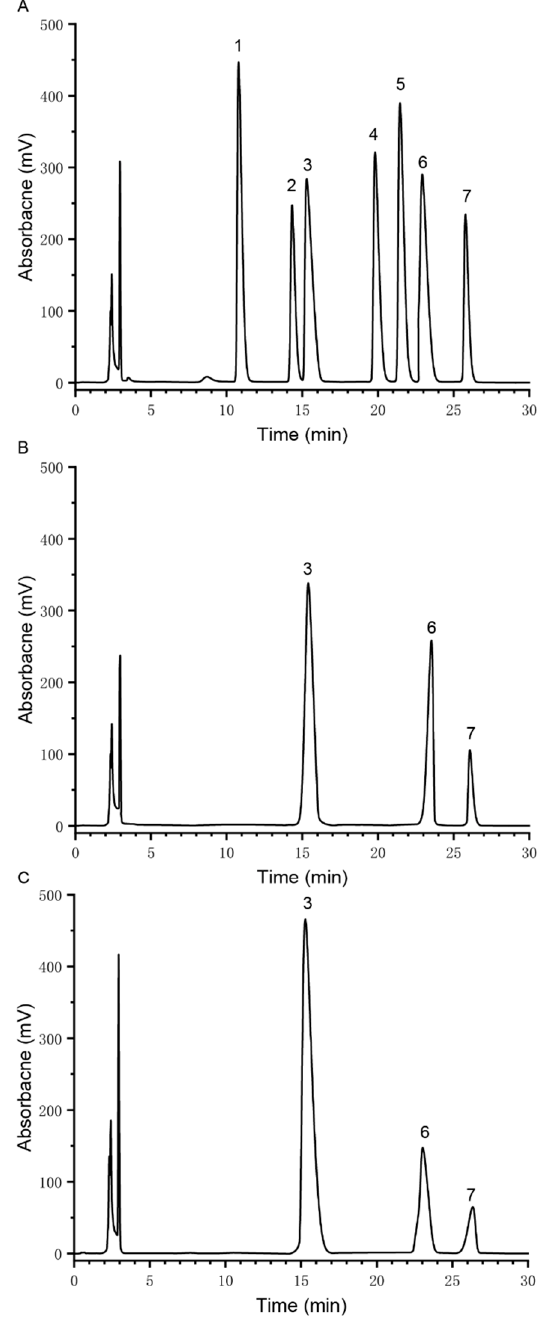
Figure 3. HPLC chromatographs of the monosaccharide standard ( A ), CTLP ‐ 1 ( B ), and CTLP ‐ 2 ( C ): 1: fructose; 2: rhamnose; 3: arabinose; 4: xylose; 5: mannose; 6: glucose; 7: galactose. 1: fructose; 2: rhamnose; 3: arabinose; 4: xylose; 5: mannose; 6: glucose; 7: